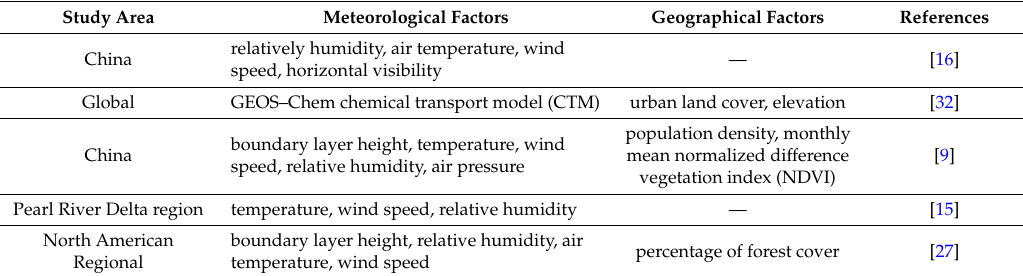
Table 1. Representatives of auxiliary variables in geographical weighted regression model (GWR) model for PM 2.5